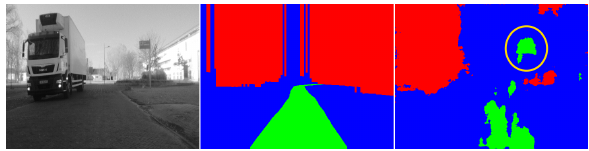
Figure 10: Test image from the WEpod dataset (left). Groundtruth label for the same test image (middle) and the output of our baseline network